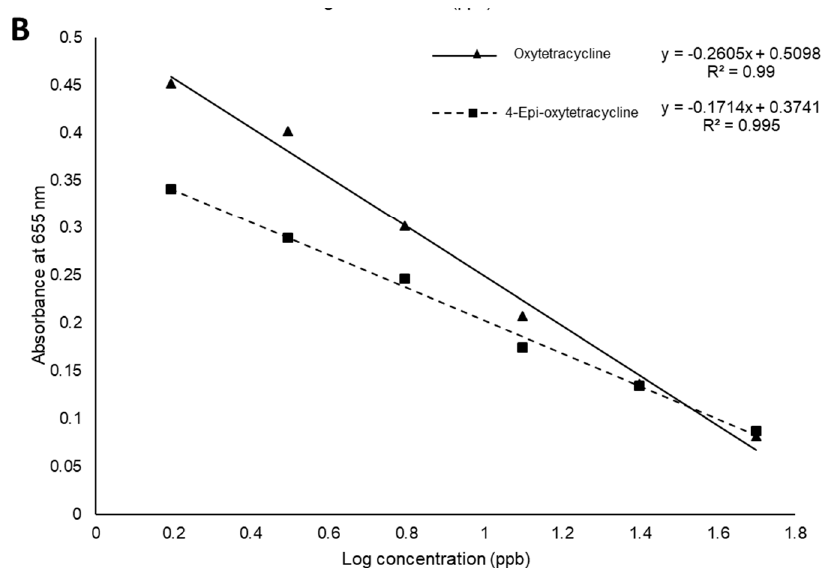
Figure 1. Cross-reactivity of the oxytetracycline metabolites with oxytetracycline ACCEL ELISA antibody. ( A ) The response of 4-epi-oxytetracycline, α -apo-oxytetracycline, and β -apo-oxytetracycline and oxytetracycline to oxytetracycline ACCEL ELISA antibody. The trendlines were fitted using second-order polynomial functions. ( B ) Standard curves for oxytetracycline and its main metabolite (4-epi-oxytetracycline) as generated with ACCEL ELISA kit TM using the average response at each concentration in the linear range (1.56–50 ng mL − 1 ). a,b,c indicate significant differences.